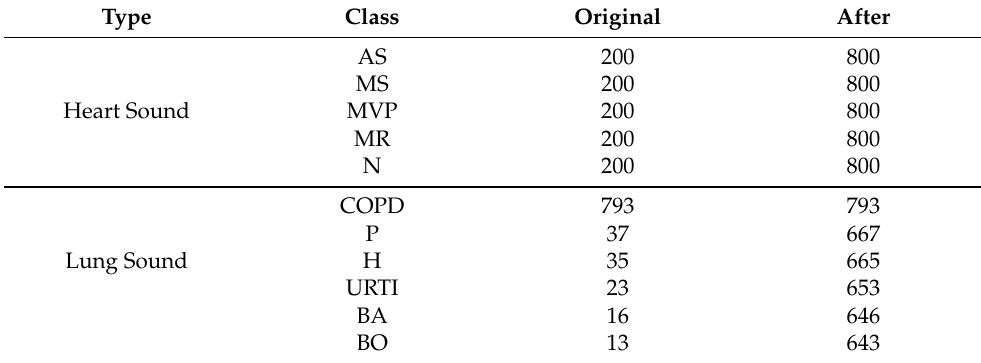
Table 1. Number of samples per class before and after augmentation